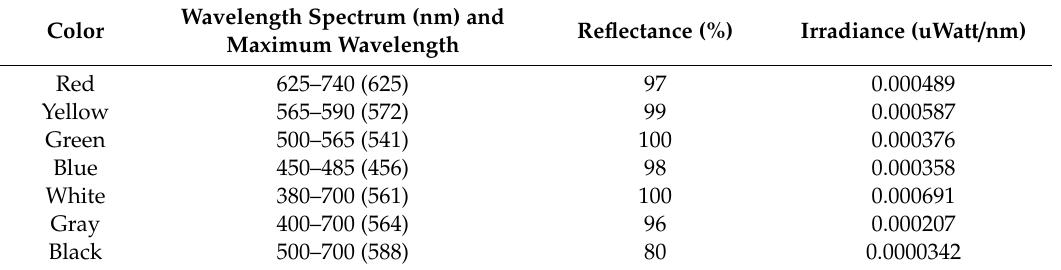
Table A2. Wavelength (spectrum), reflectance, and irradiance (emission intensity) of all color plates.